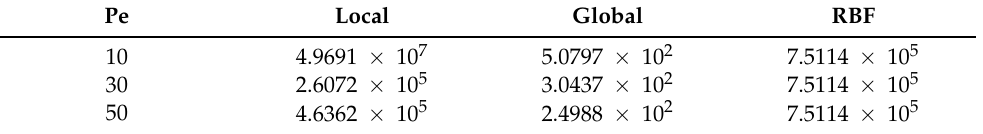
Table 10. Example No. 1—values of condition numbers, eight virtual boundary points.